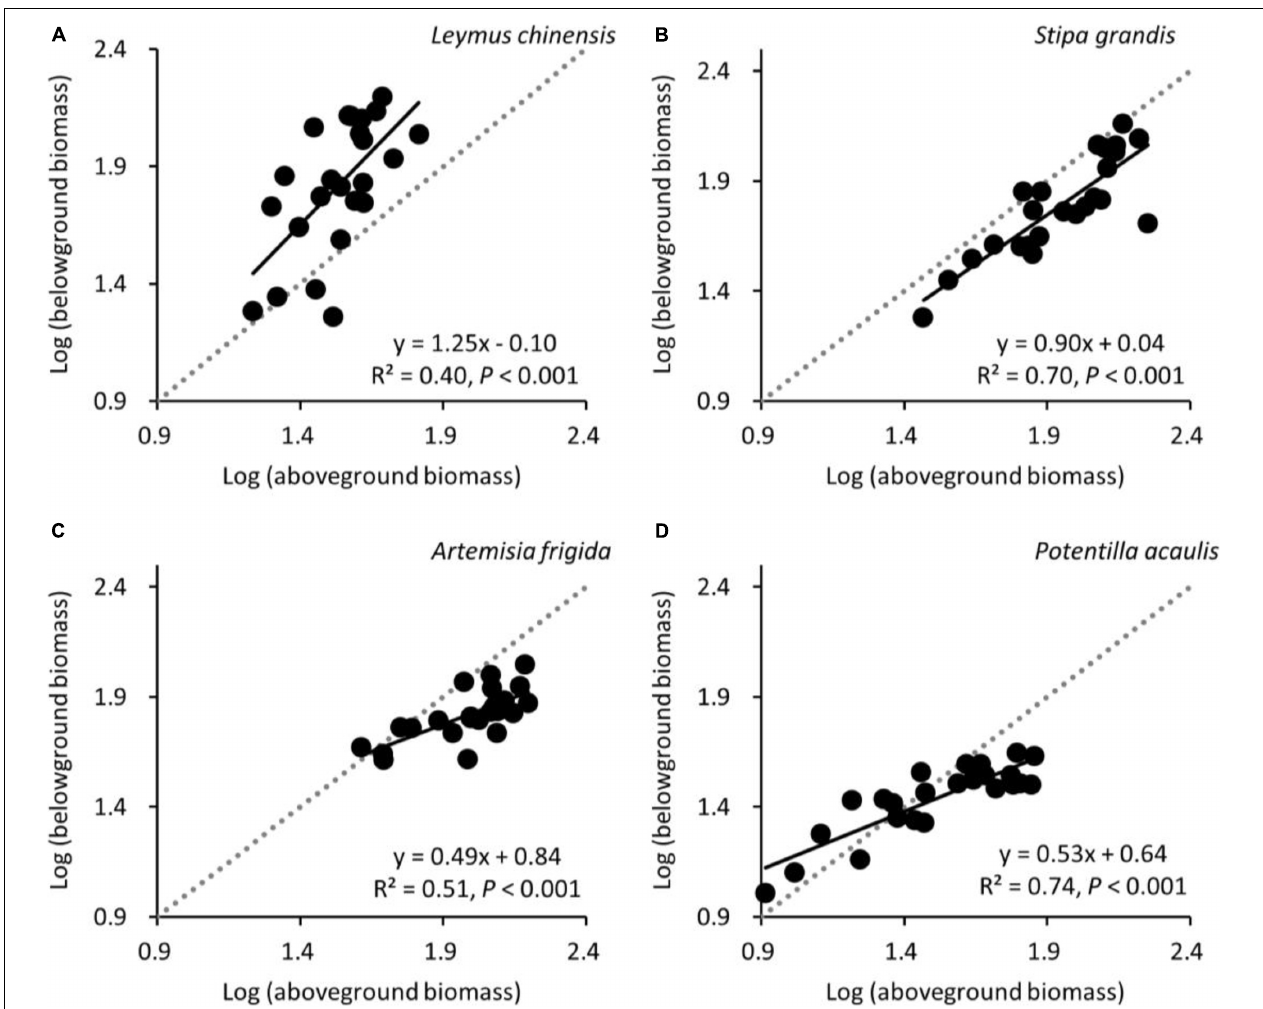
FIGURE 6 | At the pot scale, allometric relationships between log-transformed aboveground biomass and long-transformed belowground biomass for (A) Leymus chinensis , (B) Stipa grandis , (C) Artemisia frigida , and (D) Potentilla acaulis . The 1:1 line (dotted) is added for